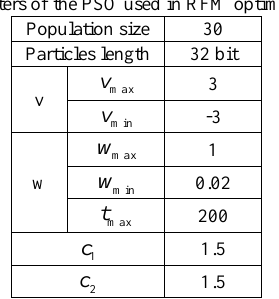
Table 2 Parameters of the PSO used in RFM